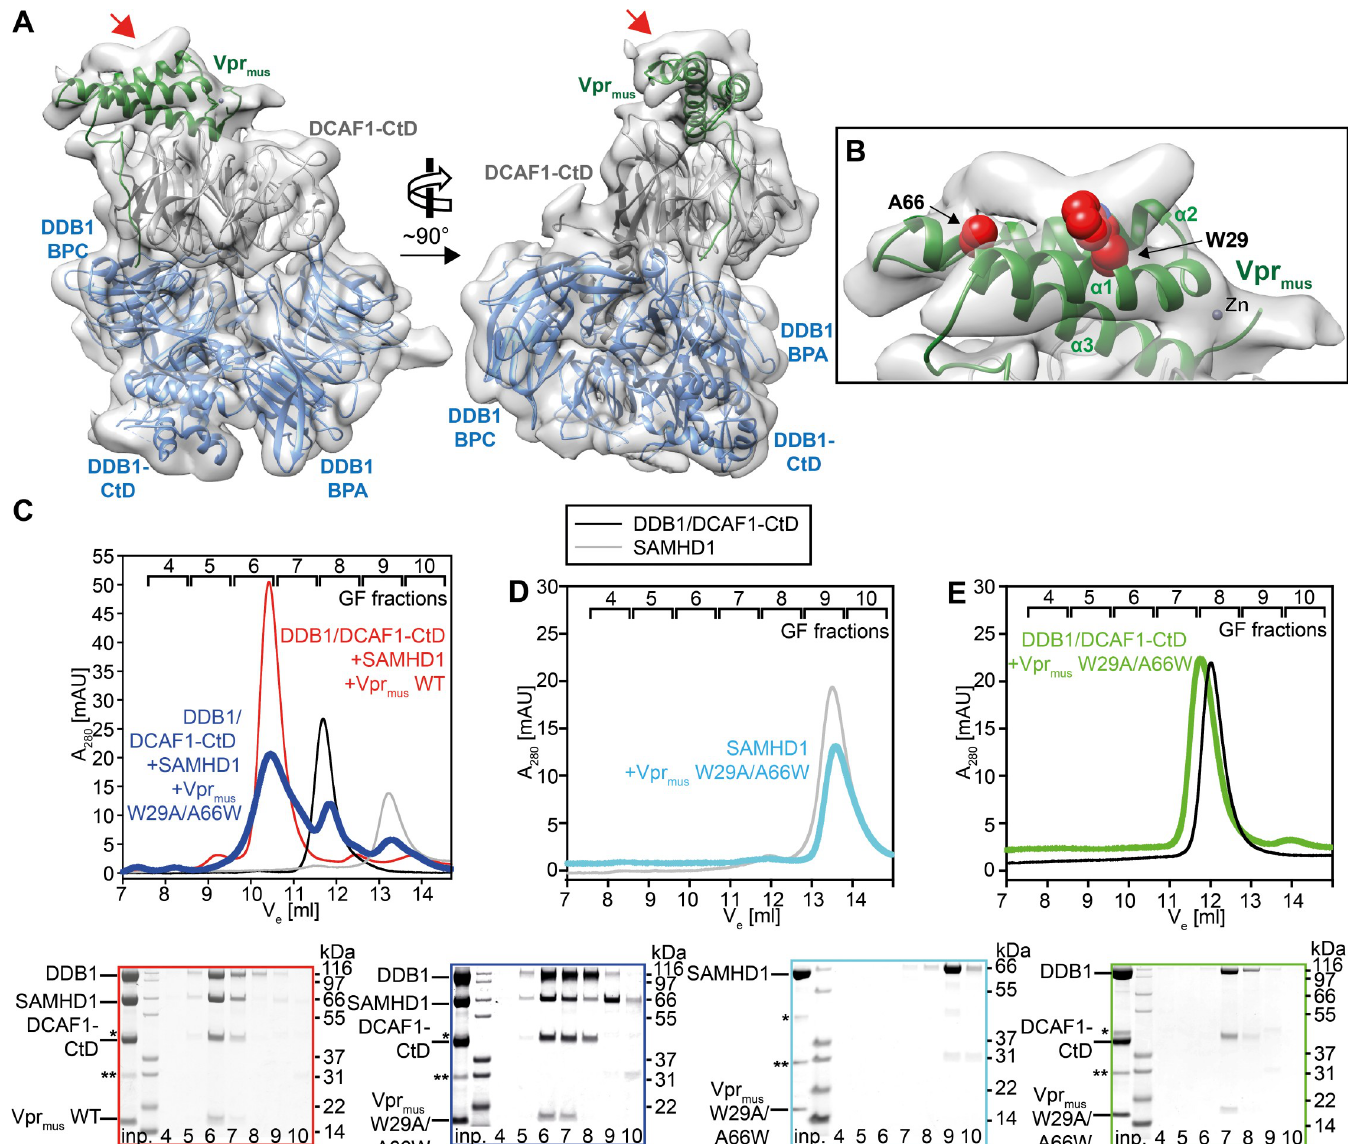
Fig 4. Mechanism of SAMHD1-CtD recruitment by Vpr mus . ( A ) Two views of the cryo-EM reconstruction of the CRL4-NEDD8 DCAF1-CtD /Vpr mus /SAMHD1 core. The crystal structure of the DDB1/DCAF1-CtD/Vpr mus complex was fitted as a rigid body into the cryo-EM density and is shown in the same colours as in Fig 2A. The DDB1 BPB model and density was removed for clarity. The red arrows mark additional density on the upper surface of the Vpr mus helix bundle. ( B ) Detailed view of the SAMHD1-CtD electron density. The model is in the same orientation as in A , left panel. Selected Vpr mus residues W29 and A66, which are in close contact to the additional density, are shown as red space-fill representation. ( C ) In vitro reconstitution of protein complexes containing DDB1/DCAF1-CtD, Vpr mus or the Vpr mus W29A/A66W mutant, and SAMHD1, assessed by analytical GF. SDS-PAGE analyses of corresponding GF fractions are shown below the chromatogram, with boxes colour-coded with respect to the chromatogram. ( D-E ) In vitro reconstitution of protein complexes containing SAMHD1 and Vpr mus W29A/A66W ( D ) or DDB1/ DCAF1-CtD and Vpr mus W29A/A66W ( E ). SDS-PAGE analyses of corresponding GF fractions are shown below the chromatogram, with boxes colour-coded with respect to the chromatogram. The asterisk and double asterisk indicate slight contaminations with remaining GST-3C protease and the GST purification tag,